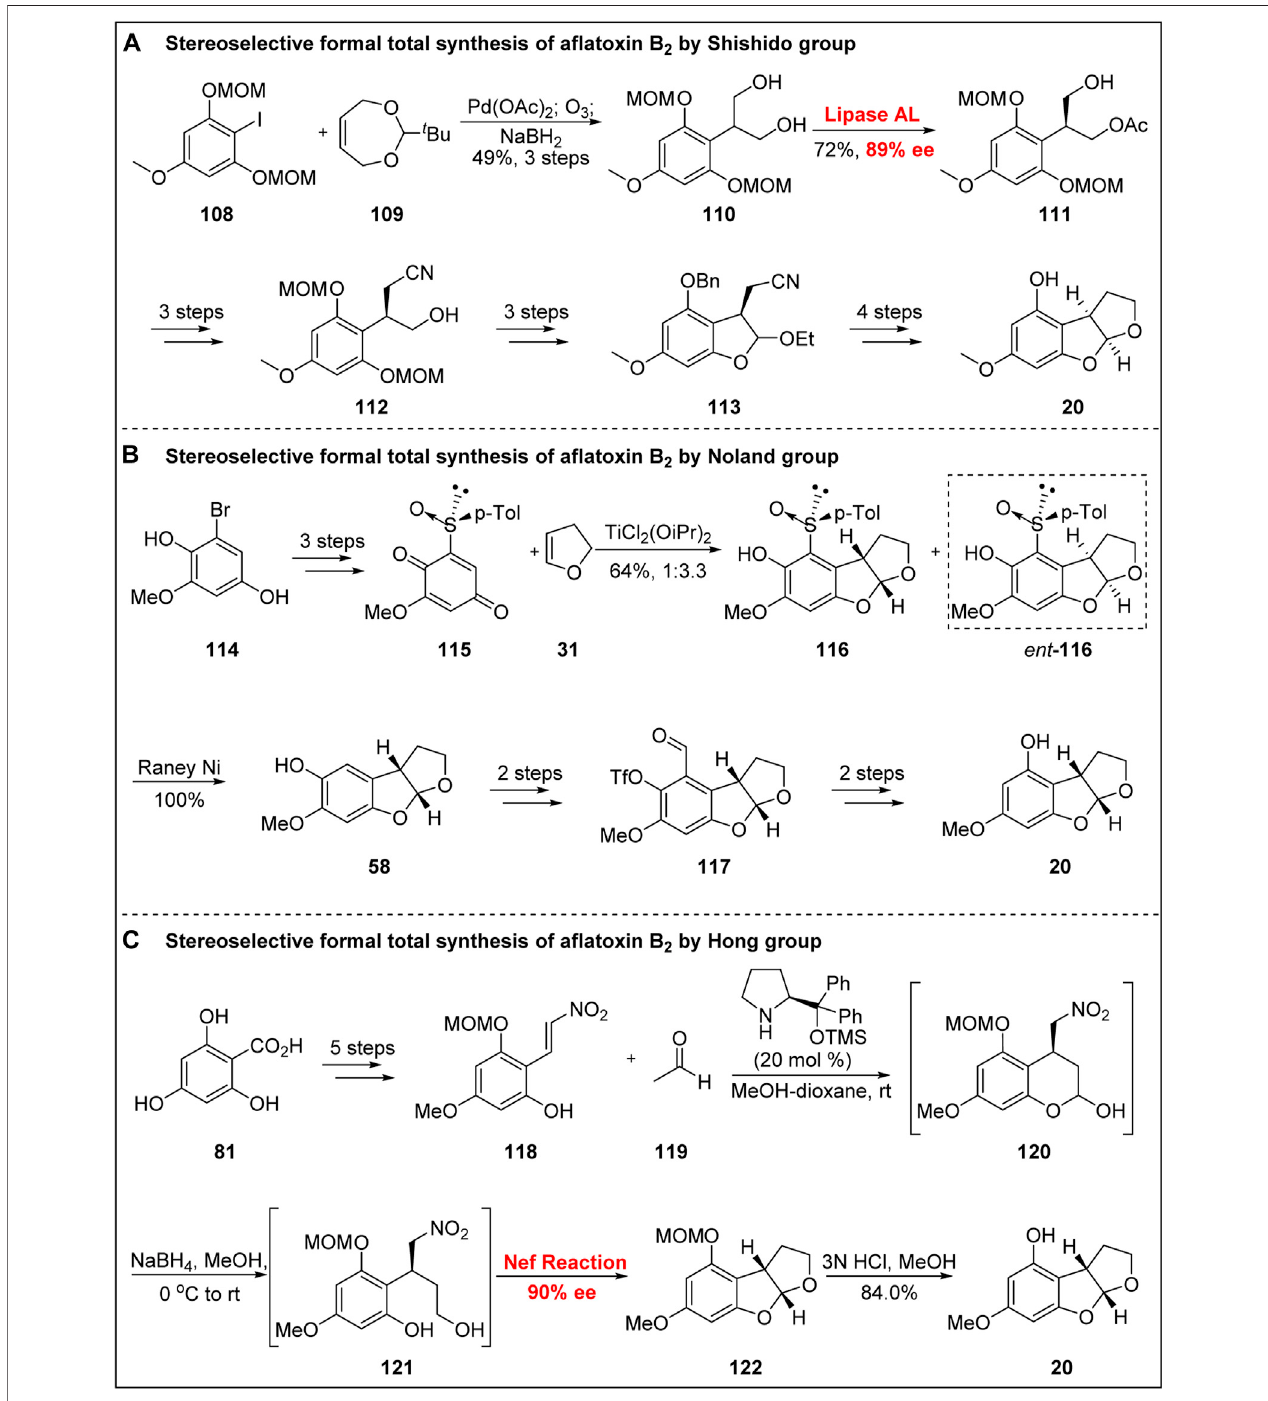
FIGURE 13 | Stereoselective formal total synthesis of a fl atoxin B